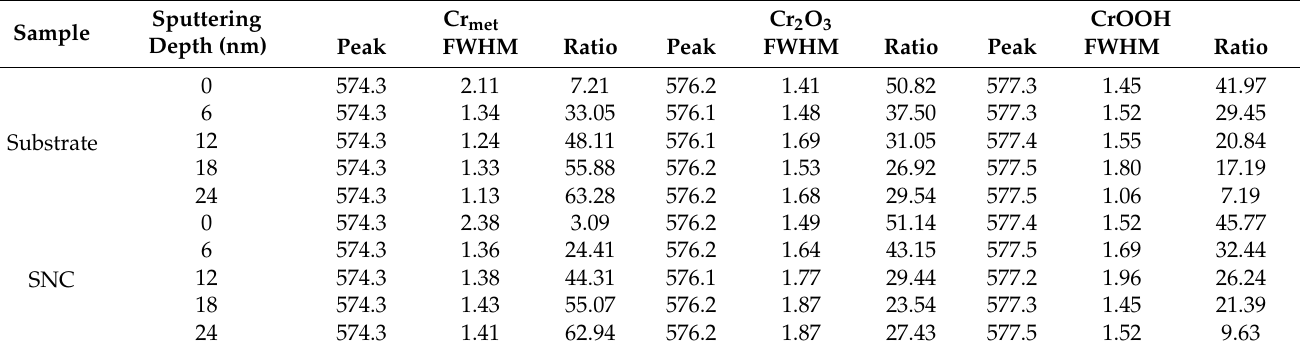
Table 4. Cr 2p 3/2 spectral fitting parameters: binding energy (eV), FWHM value (eV), and area ratio